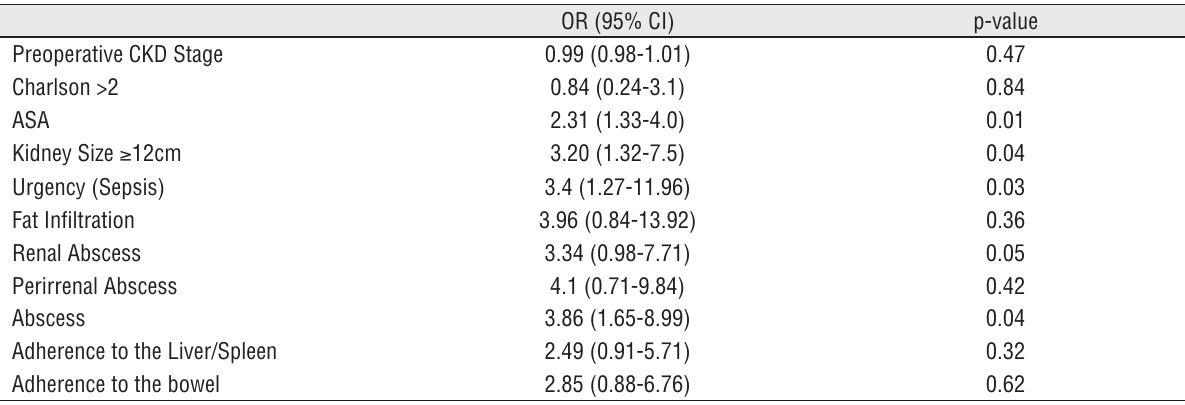
Table 4 - Multivariable logistic regression analyses predicting postoperative complications.